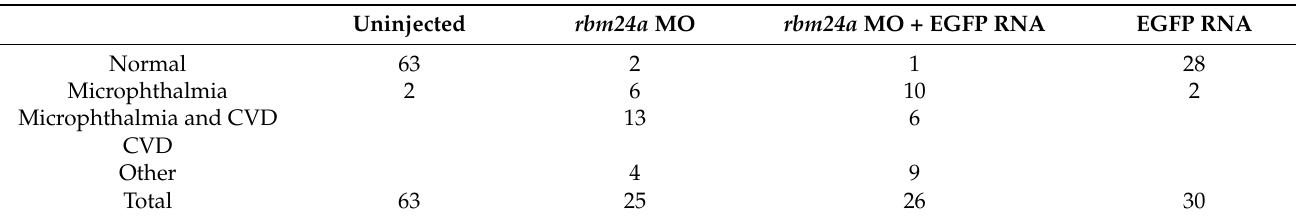
Table 3. Number of phenotypes associated with uninjected, rbm24a knockdown, rbm24a knockdown with EGFP RNA, and EGFP RNA